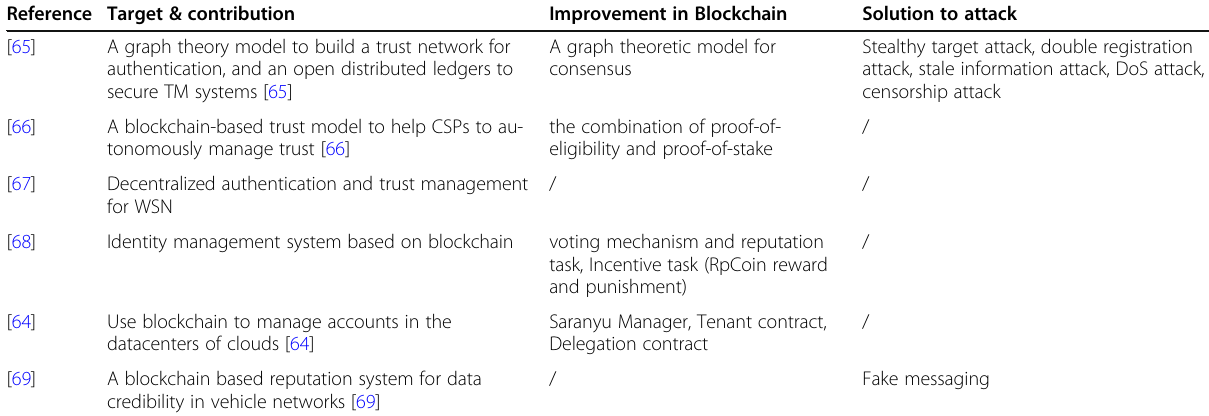
Table 3 Comparison of main contributions Reference Target & contribution